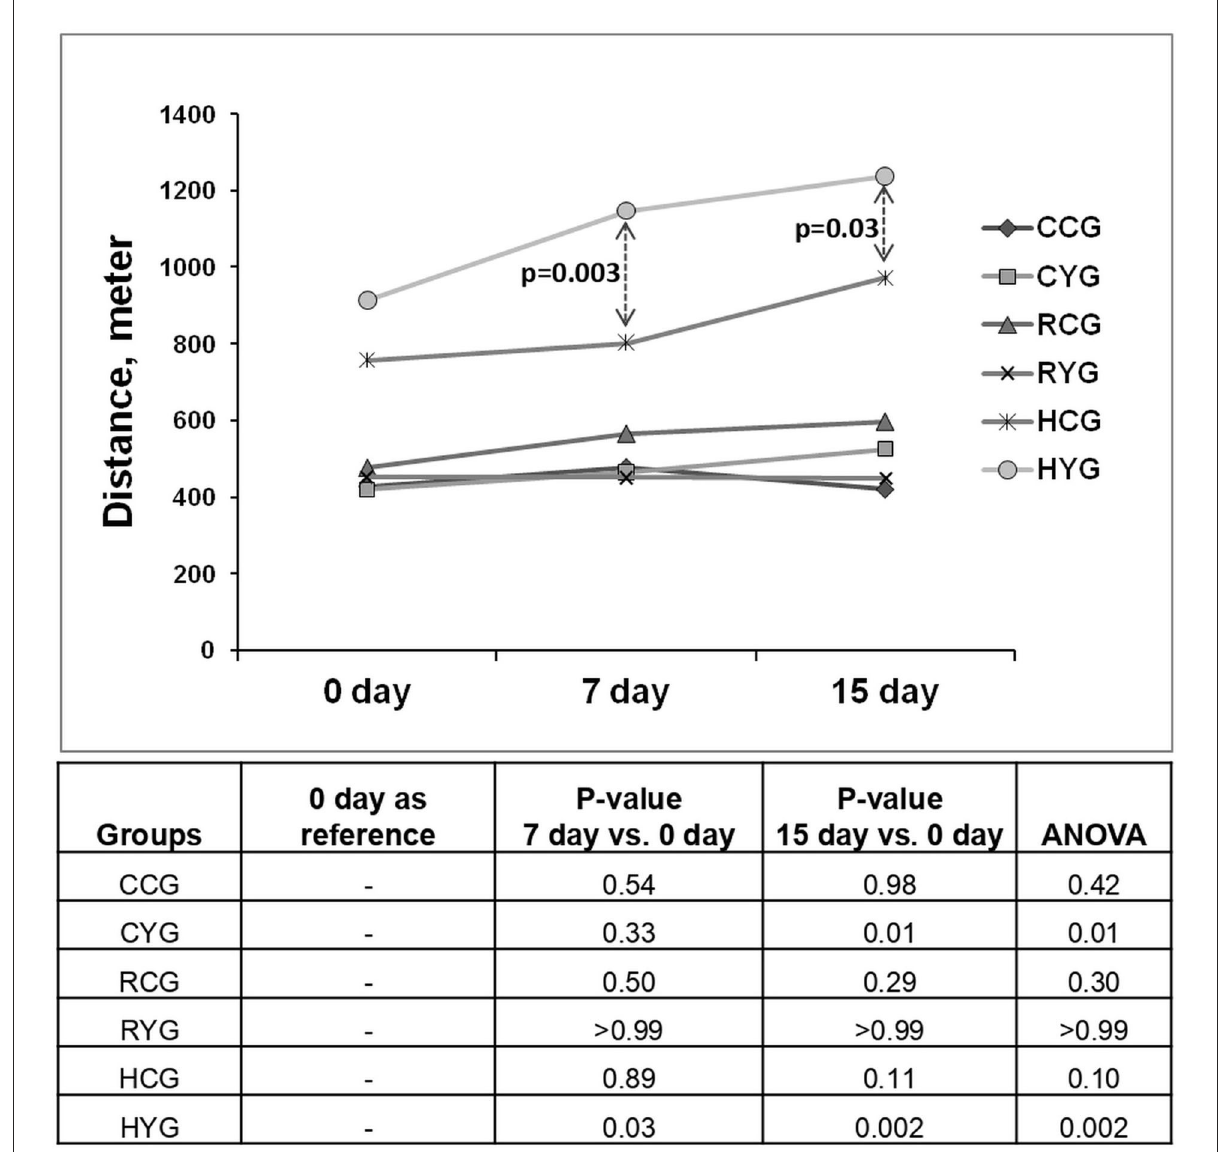
FIGURE2 Distance covered in 6-min walk test. Significance was observed at p ≤ 0.05. P -values calculated for between-group comparisons were adjusted with age and gender. CCG ( N = 10), COVID-positive control group; CYG ( N = 12), COVID-positive yoga group; RCG ( N = 8), COVID-recovered control group; RYG ( N = 10), COVID-recovered yoga group; HCG ( N = 7), HCW control group; HYG ( N = 12), HCW yoga